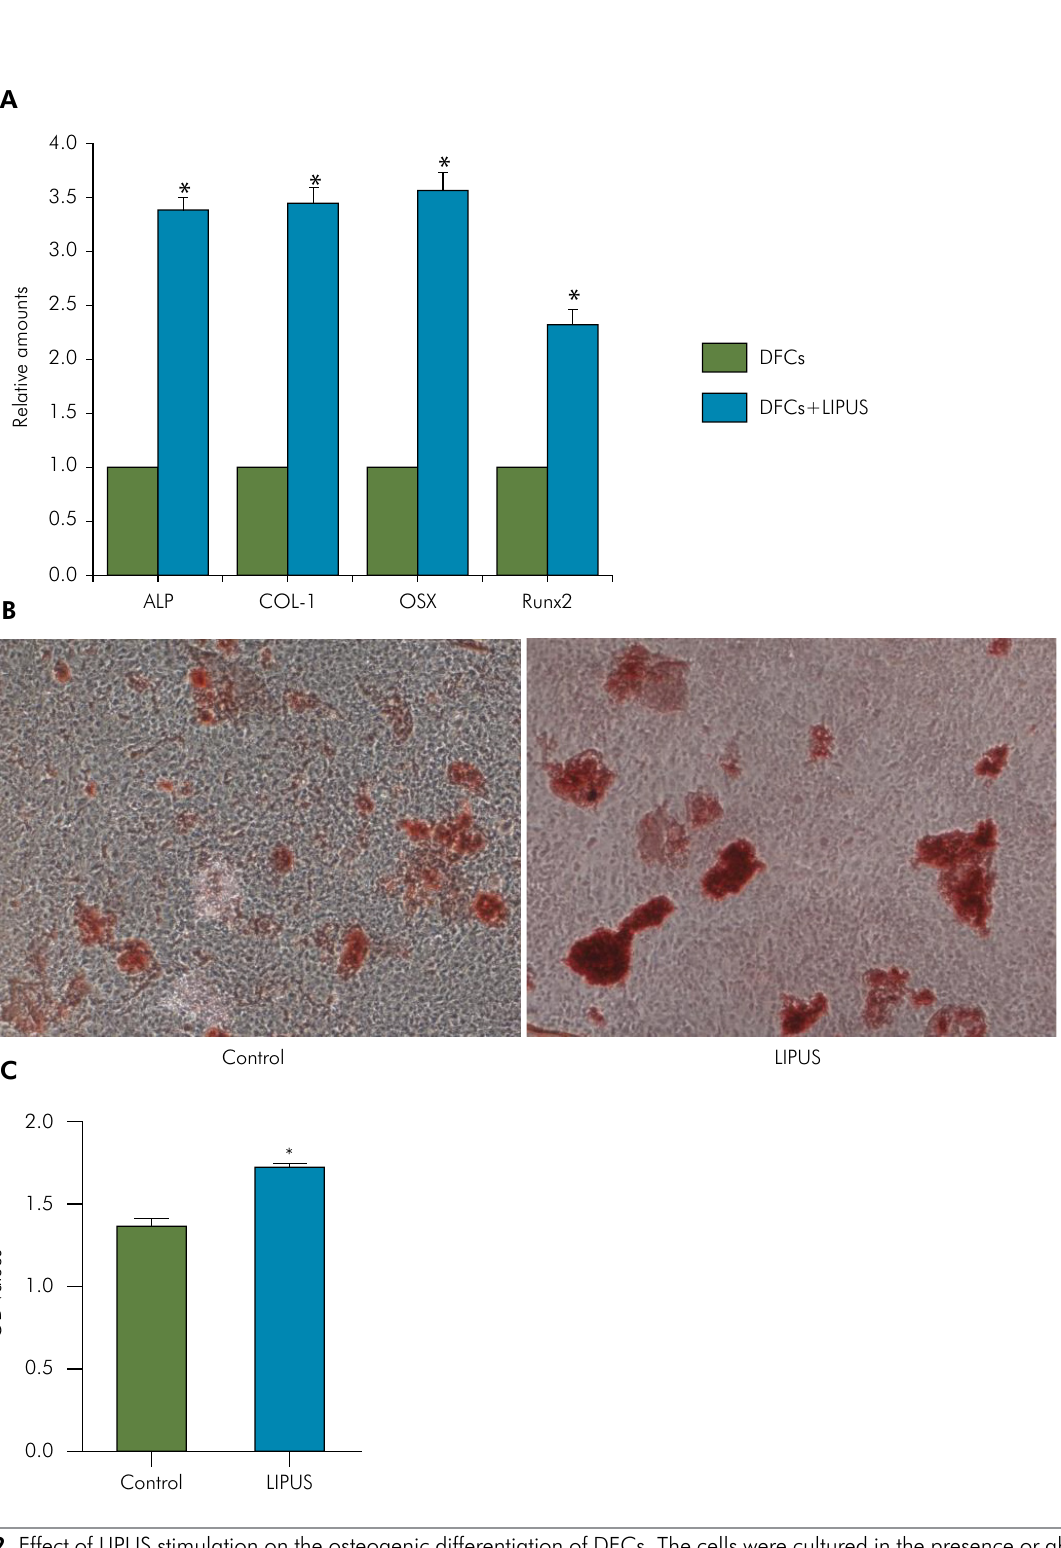
Figure 2. Effect of LIPUS stimulation on the osteogenic differentiation of DFCs. The cells were cultured in the presence or absence of LIPUS stimulation in an osteogenic medium. (−): control; (+): LIPUS stimulation. A: RT-PCR analysis of the expression levels of ALP, COL-1, OSX and Runx2 in DFC and BMSC cultures after 7 days of induced differentiation. B: The formation of mineralized nodules in DFCs was examined by staining with Alizarin red on day 21 of culture. C: The mineralization was quantified by destaining cells stained with alizarin red. P< 0.05 for LIPUS-treated versus control